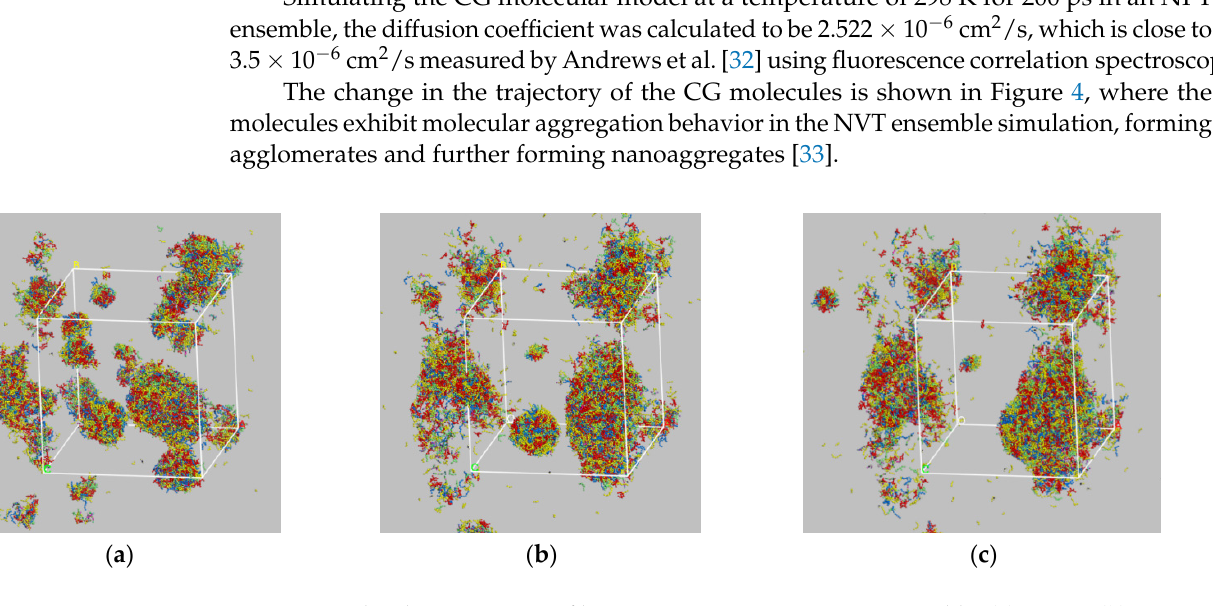
Figure 4. Molecular trajectories of bitumen CG systems at NVT ensemble. ( a ) 500 ps; ( b ) 1500